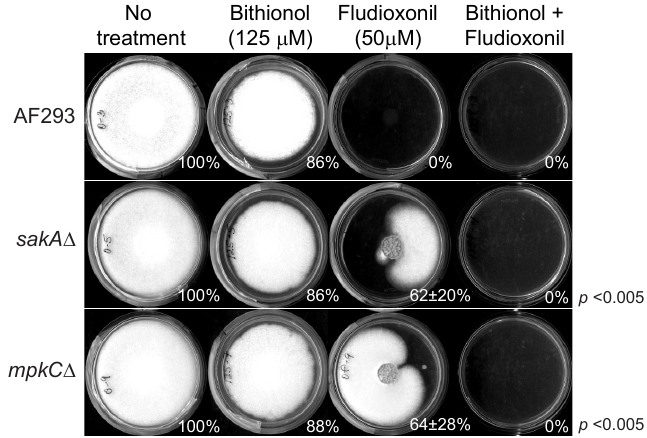
Figure 8. Bithionol overcomes fludioxonil resistance of Aspergillus fumigatus MAPK mutants.